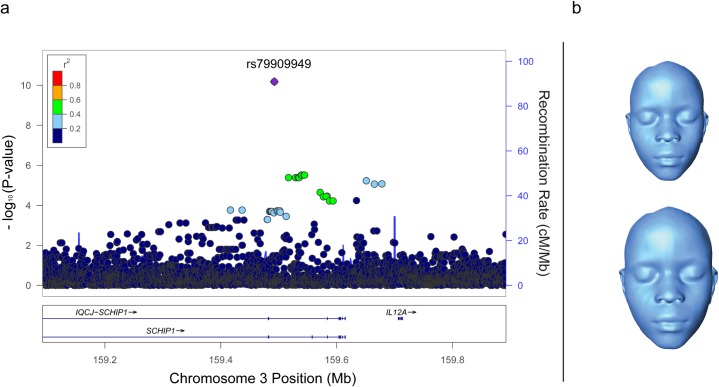
SCHIP1 locus associated with centroid size.(A) Regional association plot of centroid size at the SCHIP1 locus. Association data are shown using GWAS P-values with the meta-analysis P-value for the lead SNP, rs79909949. The LD pattern is based on the 1000 Genomes Project 2012 African reference and GRCh37/hg19. The estimated recombination rate (cM/Mb) is from HapMap samples. (B) Relative facial size at the upper and lower 95% confidence intervals for centroid size after adjusting for sex and age.